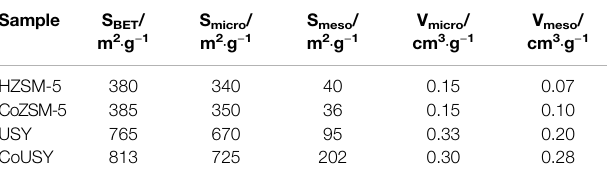
TABLE 1 | Textural properties (from low-temperature N 2 physisorption) of the studied cobalt catalysts and reference zeolites.